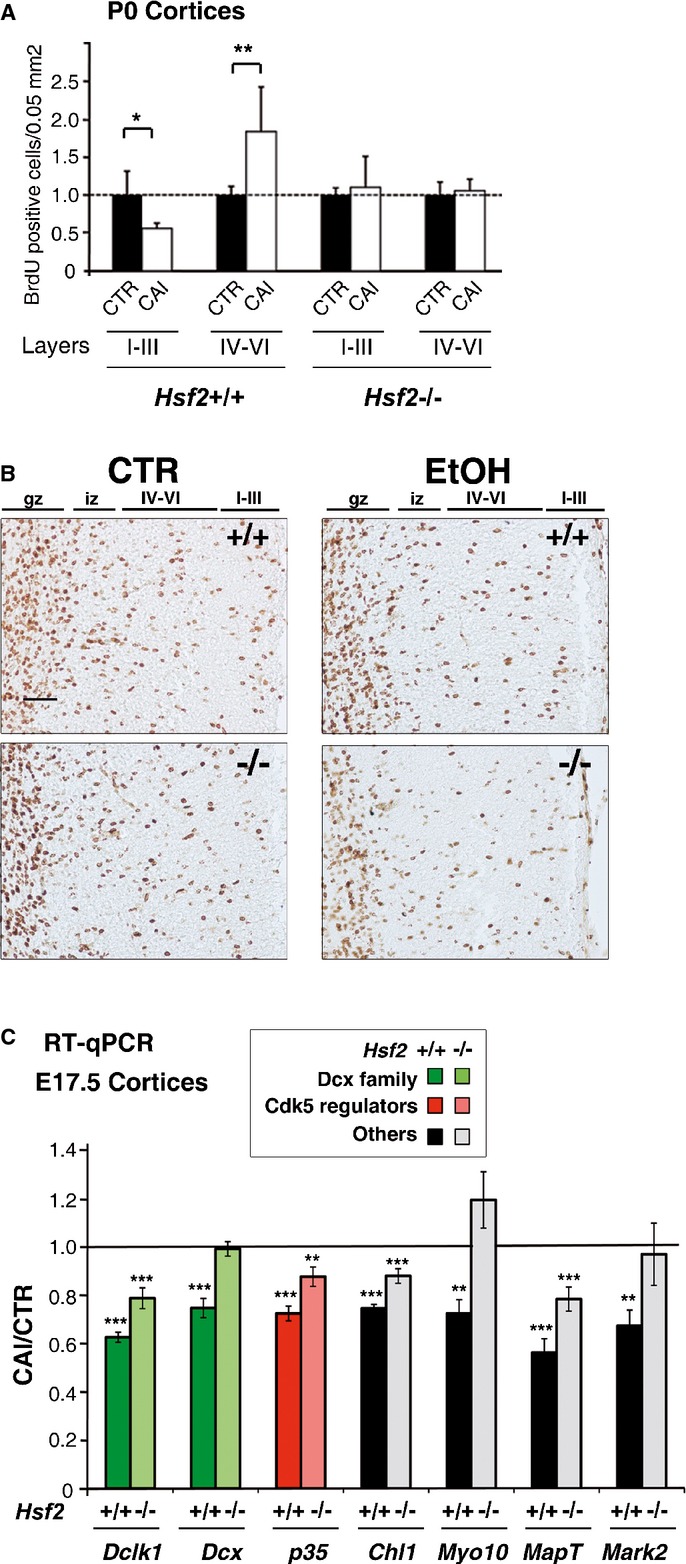
The absence of HSF2 reduces the abnormalities in neuronal positioning and disturbances in gene expression induced by fetal alcohol exposureA   Comparison of the severity of radial neuronal positioning defects between Hsf2+/+ and Hsf2−/− cortices. BrdU-labeled cells (BrdU injection at E16.5 and neuronal positioning examined at P0) in fetal cortices from pregnant dams chronically intoxicated with food containing EtOH ad libitum (CAI) per 0.05 mm2. For each genotype and group of layers, the CTR situations were set to 1 (dotted line). Superficial layers, I–III; deep layers, IV–VI. (n = 5 sections from three different individuals per condition). The ratio is significantly different from 1 in Hsf2+/+ (P-values: *P = 0.0281 for layers I–III; **P = 0.0061 for layers IV–VI) The ratio was not significantly different from 1 in Hsf2−/− (P-values: P = 0.5729 for layers I–III; P = 0.5627 for layers IV–VI). See also Supplementary Fig S11A for non-normalized data. Differences were considered statistically significant when P-values were ≤ 0.05, using unpaired two-way Student's t-test. Data are presented as mean ± SEM.B   Representative images corresponding to panels in (A). Gz, germinal zones; iz, intermediate zone; IV–VI and I–III, deep and superficial layers, respectively. Scale bar: 10 μM.C   Reduced disturbances of MAP gene expression in the absence of HSF2. Bars stand for ratios of values in CAI to those in CTR samples. Comparison of the severity of disturbances in Dclk1, Dcx, p35, Chl1, Myo10, MapT, and Mark2 expression, in RT-qPCR experiments, between E17.5 Hsf2+/+ and Hsf2−/− cortices subjected (CAI) or not (CTR) to fetal alcohol exposure (n = 4–7). A ratio of 1 is indicated by the black line. P-values (see Supplementary Table S1 for details): ***P < 0.0001; **P < 0.001. Same color code as in Figs 1C and D, and 2B. The graph represents the mean value of the ratio between each sample value and each control value. P-values were calculated by comparing ratios obtained for the control (CTR) condition versus the CAI one. For Dclk1, Dclk2, Dcx, Chl1, and p35, n = 5, individual cortices were analyzed for WT CTR; n = 7 for KO CTR, n = 6 for WT CAI; n = 4 for KO CAI. For Myo10, MapT, and Mark2, n = 3 for each conditions. Differences were considered statistically significant when P-values were < 0.05, using unpaired two-way Student's t-test. Data are presented as mean ± SEM.See also Supplementary Fig S11.